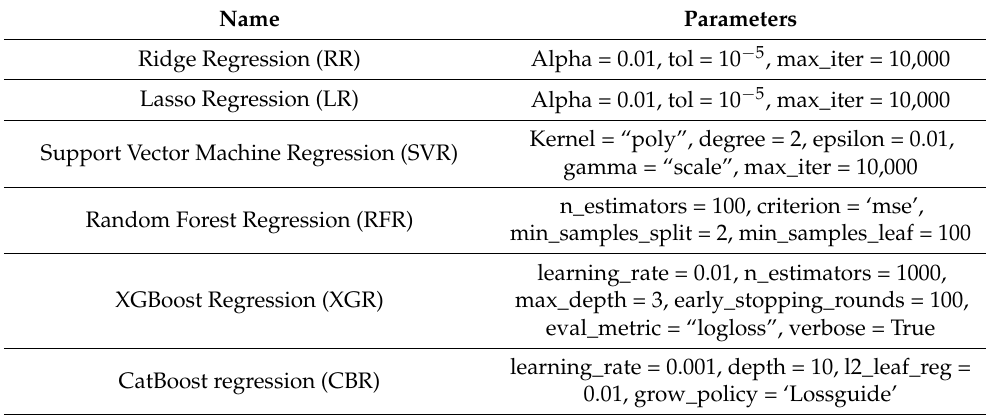
Table 2. Parameter settings of each regression